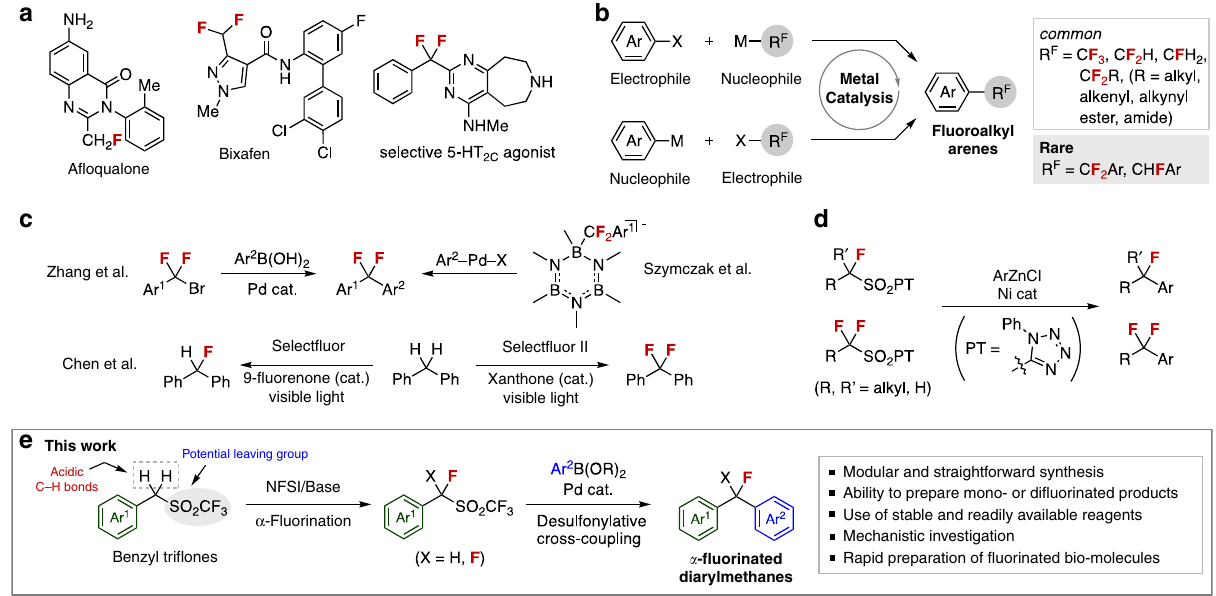
Fig. 1 Synthesis of α - fl uoromethylarenes. a Selected examples of pharmaceuticals and biologically active molecules bearing an α - fl uoromethylaryl unit. b Transition-metal-catalyzed cross-coupling reactions using fl uoroalkylating agents. c Recent advances in the synthesis of α - fl uorinated diarylmethanes through catalytic transformations. d Baran ’ s pioneering work on Ni-catalyzed radical cross-coupling of fl uoroalkylsulfones with arylzinc reagents. e This work: Pd-catalyzed desulfonylative Suzuki − Miyaura cross-coupling of α - fl uorinated benzyltri fl ones as versatile